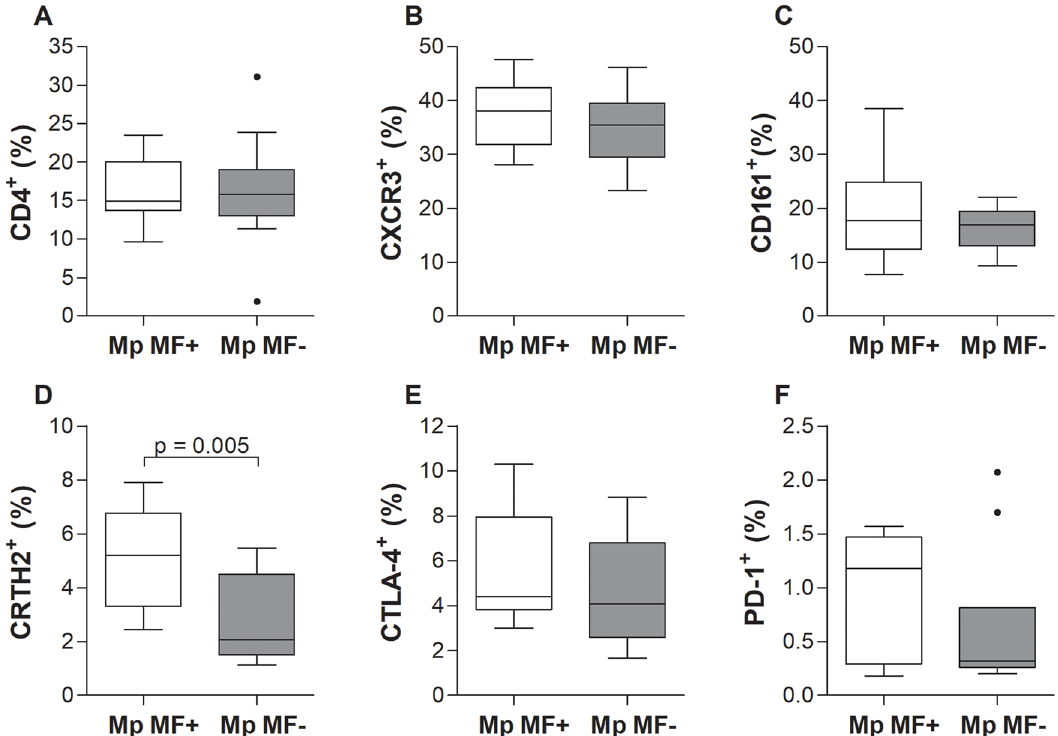
Fig 5. Increased CD4 + CRTH2 + Th2 cell frequencies in peripheral blood of M . perstans microfilaremic individuals. Using flow cytometry, peripheral whole blood cells from M . perstans microfilaremic (Mp MF+; n = 11) and amicrofilaremic (Mp MF-; n = 10) individuals were analyzed for frequencies (%) of ( A ) CD4 + T cells on lymphocytes and CD4 + T cells expressing ( B ) CXCR3, ( C ) CD161, ( D ) CRTH2, ( E ) CTLA-4 or ( F ) PD-1. Graphs show box whiskers with median, interquartile ranges and outliers. Statistical significances between the indicated groups were obtained using the Mann-Whitney-U-test.